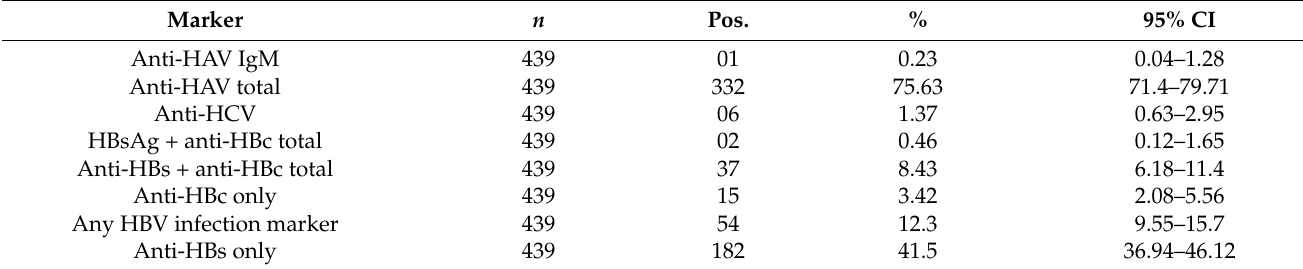
Table 2. Prevalence of viral hepatitis serological markers among transgender women.